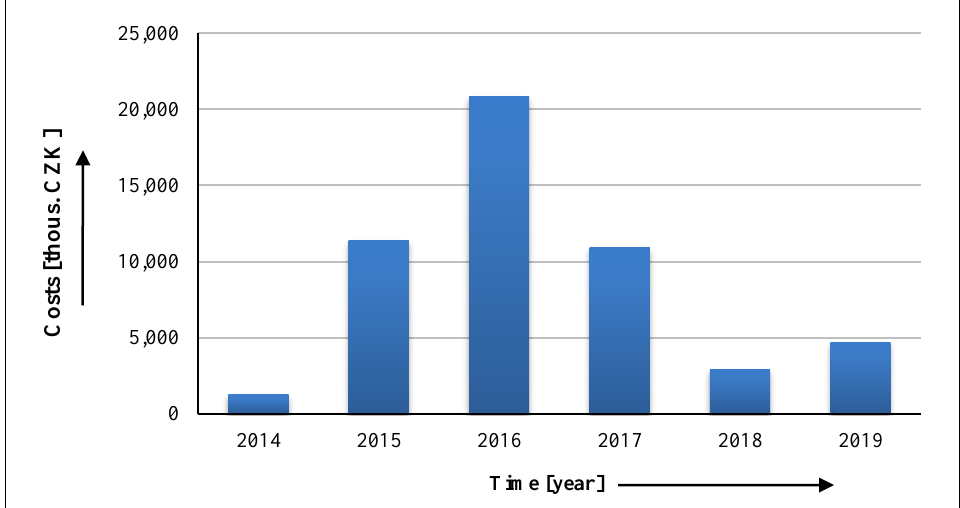
Figure 3. Development of FRSR expenditures regarding Vrbětice emergency in 2014–2019